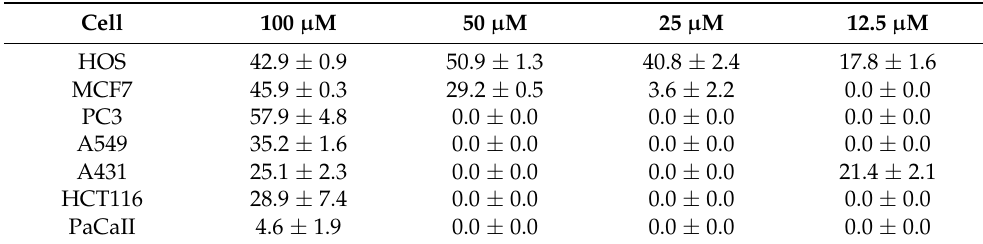
Table 3. Activity of Pep-CuNCs on tumor cell